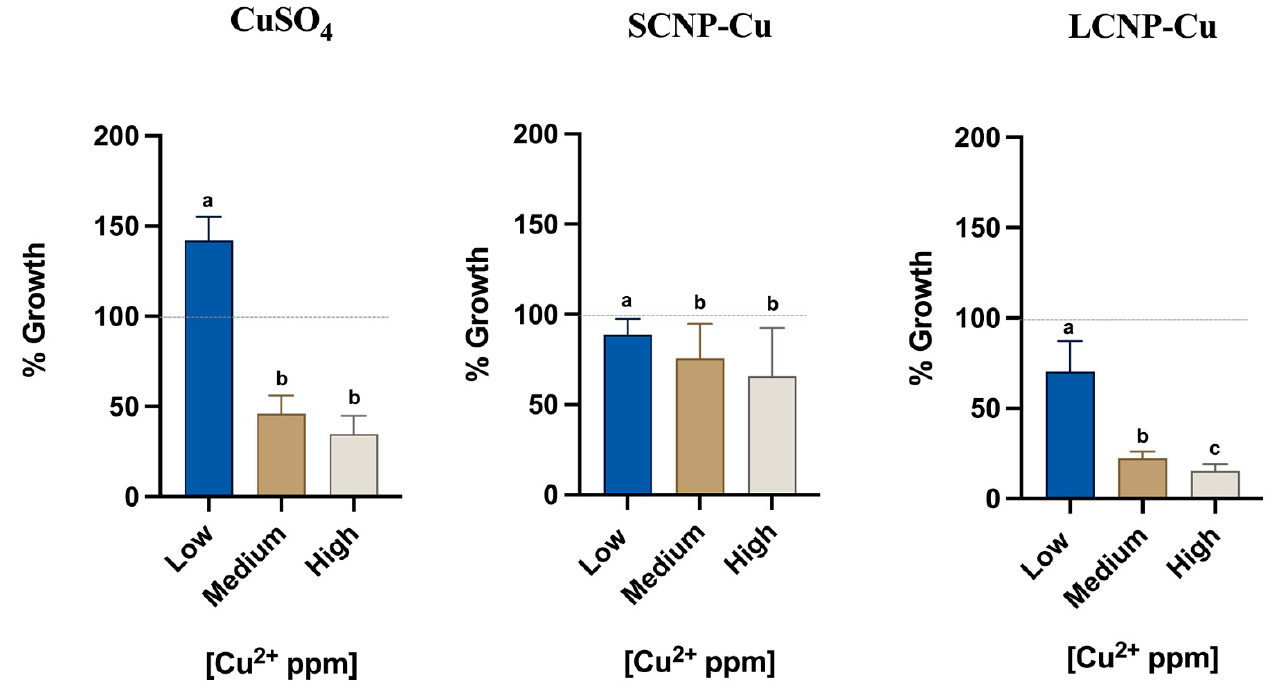
Figure 2. The antimicrobial activity of CuSO 4 , SCNP-Cu e LCNP-Cu (low, medium, high copper concentration) was evaluated against Listeria monocytogenes . The optimal growth condition of Listeria monocytogenes as a negative control (10 9 CFU/mL) during the MIC experiments is indicated as 100% on the y -axis (dashed gray line). The x -axis represents the copper concentration (low, medium and high) for each antimicrobial. Average values are used for the histogram representation, and values with different superscript letters (a, b, c) are significantly different ( p < 0.05).